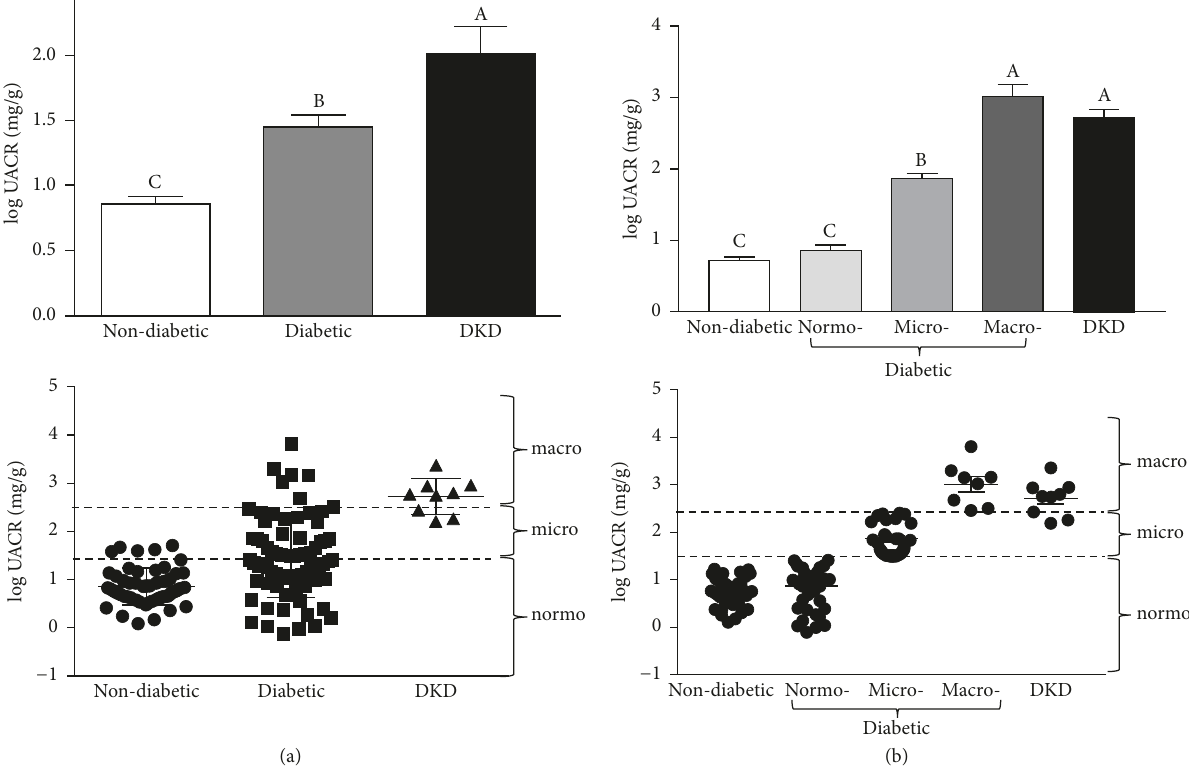
Figure 3: Urinary albumin to creatinine ratios (UACRs). (a) Log-transformed UACRs among nondiabetic controls, diabetic patients with no known kidney disease, and diabetic patients with diagnosed diabetic kidney disease (DKD). Data are represented as both a bar chart showing mean log UACR ± SEM within each group (top) and a scatter plot showing values for each individual within the group (bottom). UACR levels corresponding to normo- ( log UACR < 1.47) , micro- (1.47 < log UACR < 2.47) , and macroalbuminuria ( logUACR > 2.47) are indicated by dashed lines. (b) Log-transformed UACR as in (a), except that diabetic patients with no known kidney disease have been subdivided into normo-, micro-, and macroalbuminuria based on their UACRs. Labels without a common letter are significantly different from one another (𝑝 < 0.05) based on one-way ANOVA and Tukey’s honest significant difference